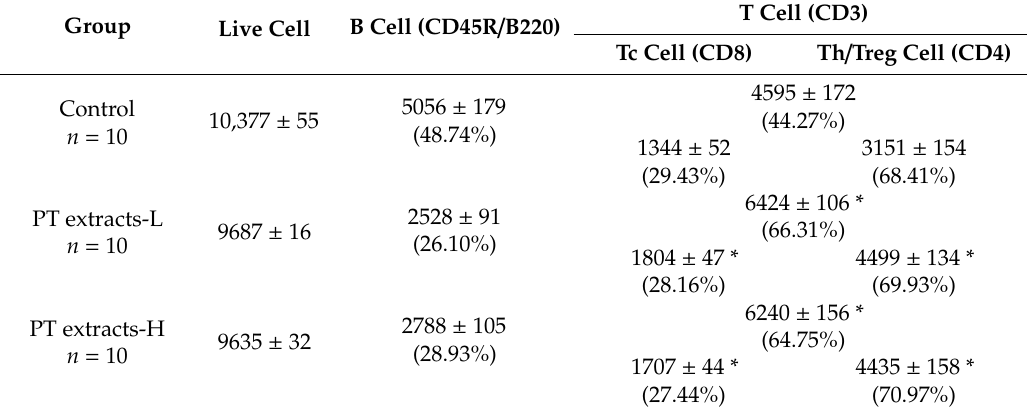
Table 3. The distribution of immune cells, including B cells and T cells, in splenocytes isolated from normal diet-fed mice.